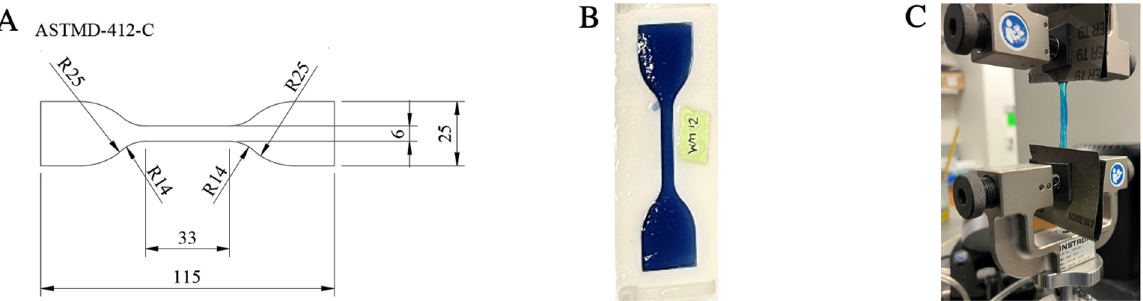
Figure 1. Alginate specimens molded for mechanical tensile testing and swelling ratio assessment. ( A ) ASTMD-412-C specified dimensions. All units are in millimeters. ( B ) 3D-printed molds were used to cast alginate specimens with ASTM D412-C specified dimensions. ( C ) The alginate specimens were secured to an Instron tester for Young’s modulus measurement.